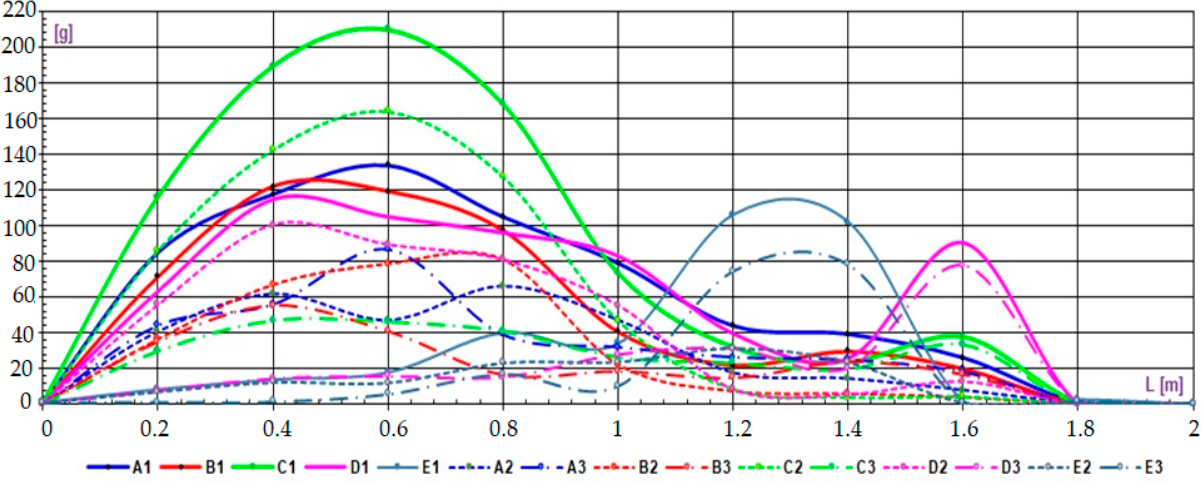
Figure 4. The variation of total separated material (straw + seeds), M s , mass of seeds separated, M d , and mass of straw separated in each section (A, B, C, D, E) of the length of the threshing apparatus; A1, B1, C1, D1, E1—the total separated material (straw + seeds), M s , on each section of the threshing apparatus length; A2, B2, C2, D2, E2—mass of seeds separated, M d , on each section of the threshing apparatus length; A3, B3, C3, D3, E3—mass of straw separated on each section of the threshing apparatus length.